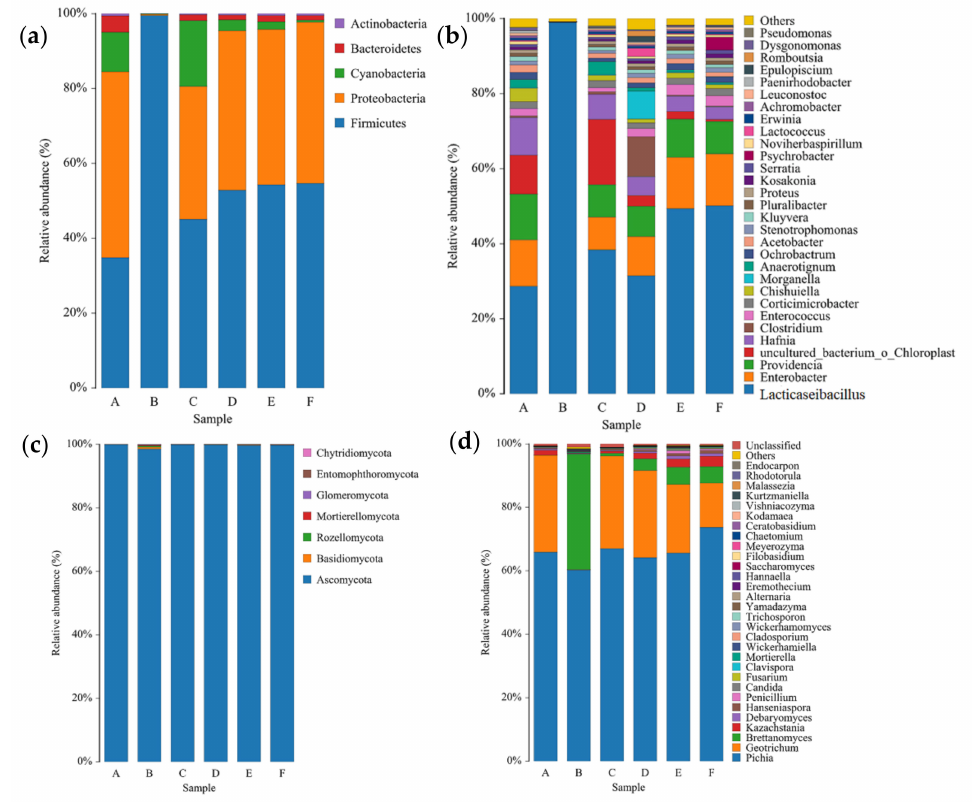
Figure 3. The relative abundance of bacteria and fungi in CTN at the phylum level ( a , c ) and genus level ( b , d ). Each phylum or genus is represented by a unique color. Each column represents a different studied sample of CTN (A–F). CTN refers to the traditional tomato sour soup